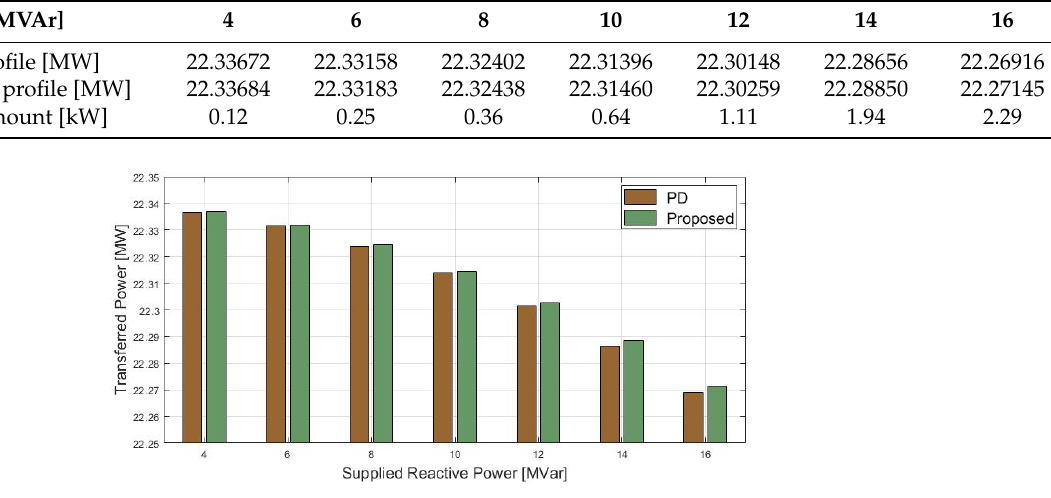
Figure 9. Comparison of transferred active power in the case studies. Figure 10 indicates the calculated loss occurring on each array for different reactive power requirements on the wind farm when applying PD and the proposed method. As shown in the published paper, with the increase of the reactive power requirement, the absolute value of the change in power loss increases for each array and it is observed that all the power losses for arrays are standardized.